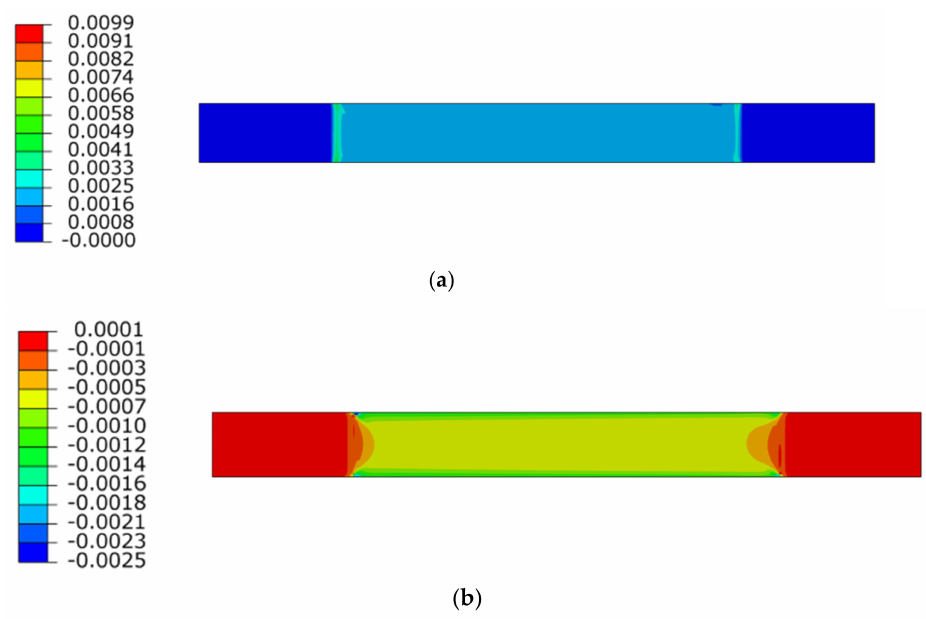
Figure 10. Principal strain field distribution, Vertical ( a ), Horizontal ( b ).